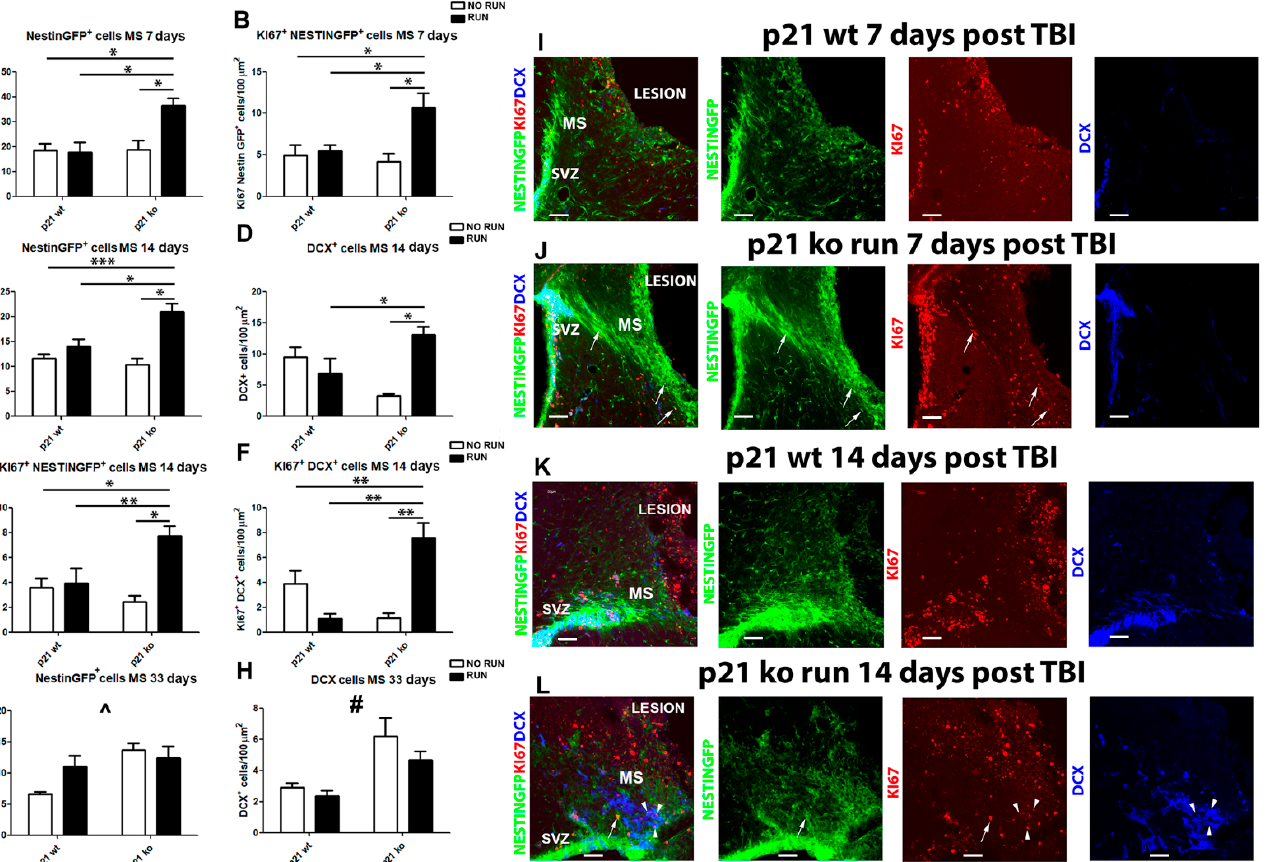
Figure 5. Cell migration following TBI. ( A ) Graph shows the increase in the migratory stream (MS) of the KO RUN TBI mice in comparison to the other groups 7 days after the lesion of NestinGFP + cells (genotype x running: F( 1.18 ) = 5.98, p = 0.025, followed by LSD post-test, KO RUN TBI vs. WT TBI, p = 0.017, vs. WT RUN TBI, p = 0.031 and vs. KO TBI p = 0.027). ( B ) Graph shows the increase in proliferating NSPCs in the migratory stream (MS) of the KO RUN TBI mice 7 days after the lesion (Ki67 + Nestin GFP + cells: genotype x running: F( 1,18 ) = 5.51, p = 0.03, followed by LSD post-test, KO RUN TBI vs. WT TBI, p = 0.027, vs. WT RUN TBI, p = 0.038 and vs. KO TBI p = 0.049). ( C ) Histograms illustrate the enhancement in the MS of KO RUN TBI mice with respect to the other experimental condition 14 days after the TBI of NestinGFP + cells (genotype x run interaction: F (1,18) = 6.55, p = 0.019, followed by LSD post-test, KO RUN TBI vs. WT TBI, p < 0.001, vs. WT RUN TBI, p = 0.01 and vs. KO TBI, p = 0.023). ( D ) Graph shows the increment, with respect to the other experimental conditions of DCX + cells, in the MS of KO RUN TBI 14 days after TBI (genotype x run interaction: F (1,18) = 7.07, p = 0.016, followed by LSD post-test, KO RUN TBI vs. WT RUN TBI, p = 0.024 and vs. KO TBI, p = 0.02). ( E ) Graph shows the increase in the MS of KO RUN TBI mice with respect to the other groups 14 days after the TBI of proliferating NestinGFP + (Ki67 + /NestinGFP + : genotype x run interaction: F (1,18) = 5.07, p = 0.037, followed by LSD post-test, KO RUN TBI vs. WT TBI, p = 0.007, WT RUN TBI, p = 0.038 and vs. KO TBI, p = 0.0073). ( F ) Graph shows the increments, with respect to the other experimental conditions of proliferating DCX + cells, in the MS of KO RUN TBI 14 days after TBI (Ki67 + DCX + cells: genotype x run interaction: F (1,18) = 7.07, p = 0.016, followed by LSD post-test, KO RUN TBI vs. WT TBI, p = 0.004, WT RUN TBI, p = 0.008 and vs. KO TBI, p = 0.0018). ( G ) Graph indicates an increase in migrating NestinGFP + cells in the KO TBI and KO TBI RUN mice with respect to the WT TBI mice 30 days after TBI (genotype effect: F (1,25) = 3.34, p = 0.011, ^). ( H ) Histograms show an enhancement of migrating DCX + cells in the KO TBI and KO TBI RUN group with respect to the WT TBI mice 30 days after TBI (genotype effect: F (1.25) = 12.64, p = 0.0015, #). ( I , J ) Confocal micrographs show the increased density of migrating NestinGFP + cells observed in the KO RUN TBI mice with respect to the WT TBI mice, 7 days from TBI. ( K , L ) Confocal micrographs illustrate the enhancement of NSPCs (NestinGFP + ) and neuroblasts (DCX + ) along the MS of the KO RUN TBI mice compared to the WT TBI group, 14 days post TBI. Arrow indicates the presence of proliferating NestinGFP + cells and arrowheads indicate proliferating DCX + cells. N = 5 mice/group.